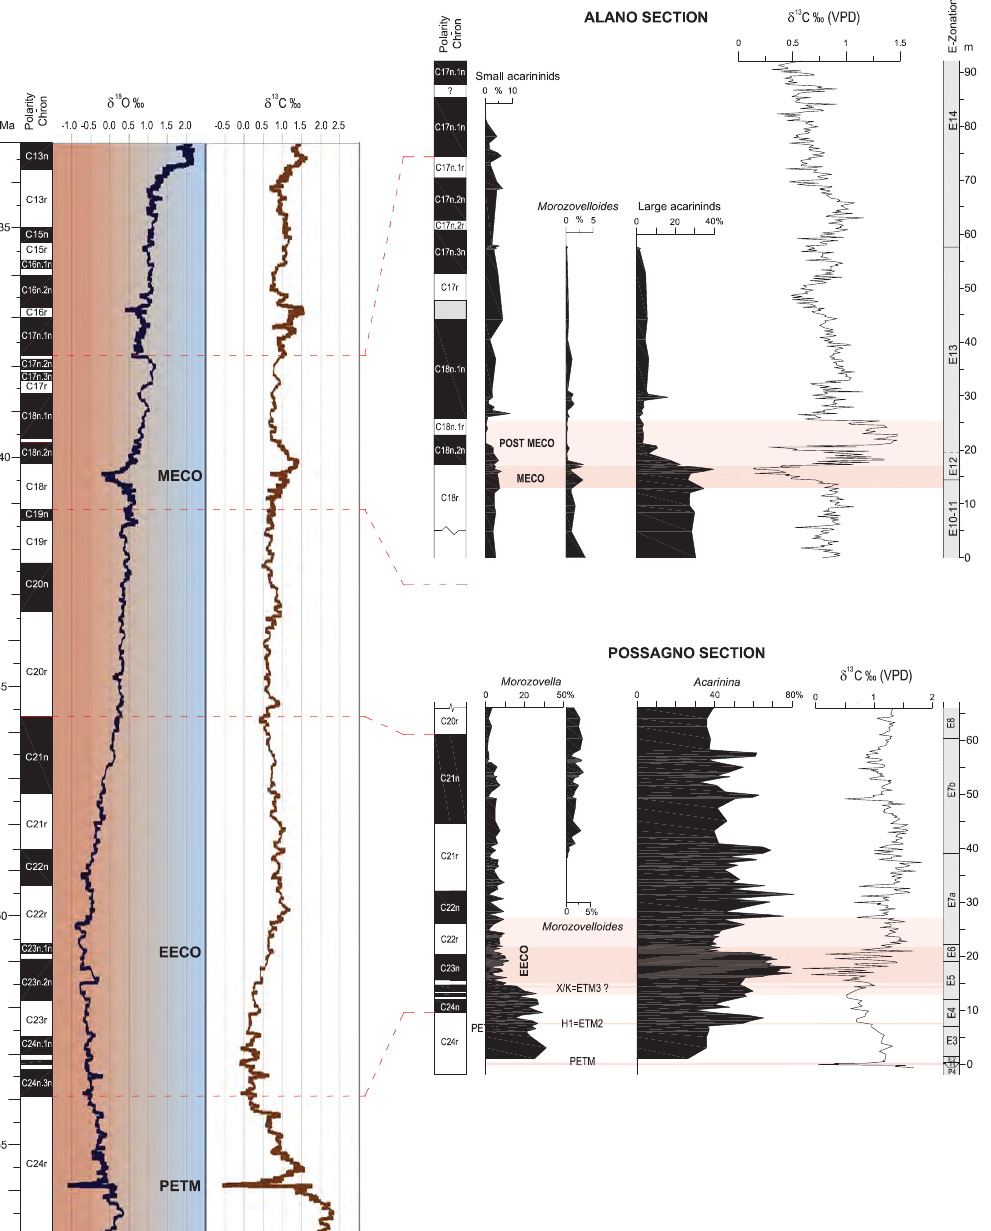
Figure 11. Records of Morozovella and large Acarinina (>200micron) in the western Tethyan setting from the Possagno section (this paper) and the Alano section (Luciani et al., 2010), plotted with generalized δ 13 C and δ 18 O curves for benthic foraminiferal on the GTS2012 (as summarized by Vandenberghe et al. (2012); slightly modified). These records suggest that the long-lasting EECO and MECO intervals of anomalous warmth mark two main steps in the decline in Morozovella , Morozovelloides and Acarinina . The planktic foraminiferal biozones follow those presented by Wade et al. (2011), as partly modified by Luciani and Giusberti